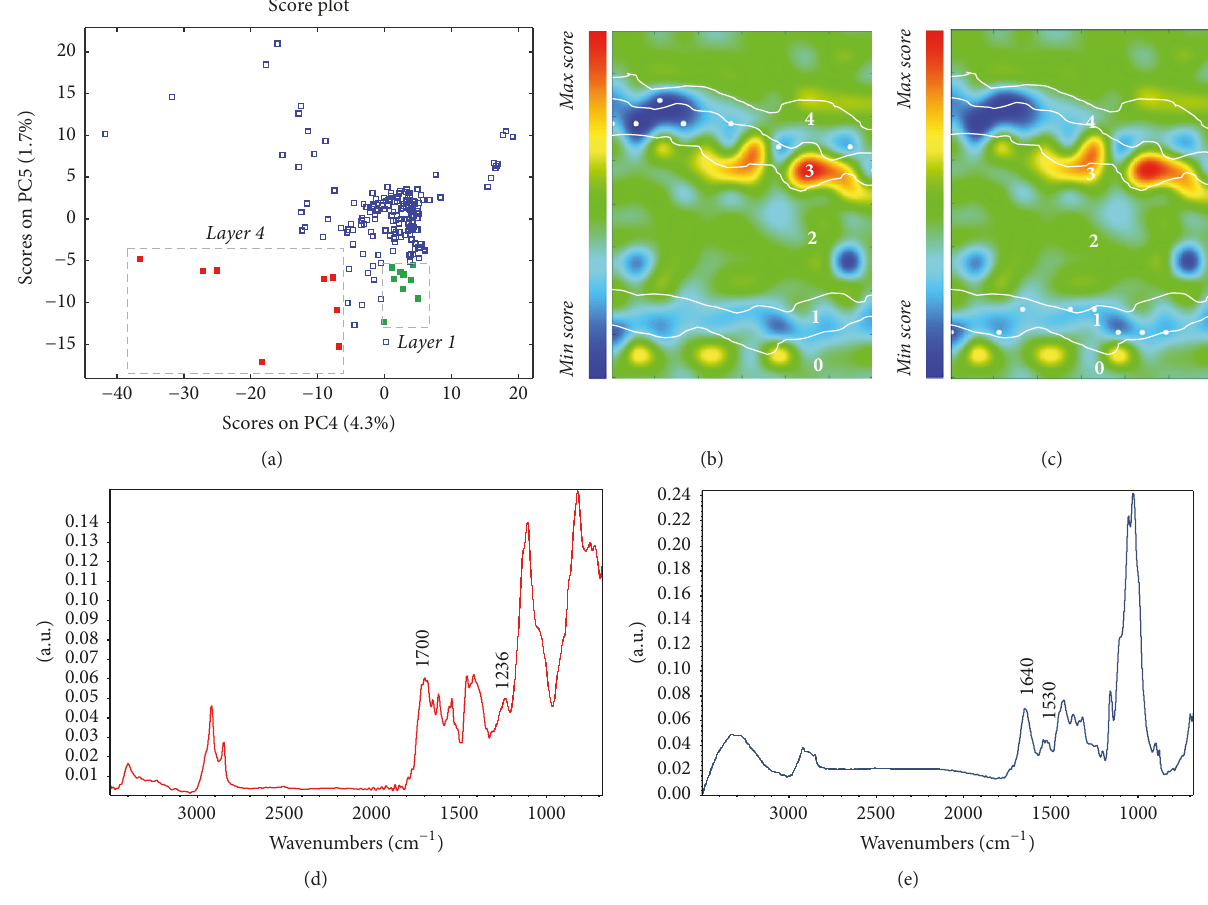
Figure 10: Sample BC1—(a) PC45 score plot: cluster highlighted in red indicates the objects points localised within layer 4 (white dots in (b)) and cluster highlighted in green indicates the objects in layer 1 (white dots in (c)); (b and c) PC5 score maps; (d) average spectral profile extracted from layer 4; (e) average spectral profile extracted from layer